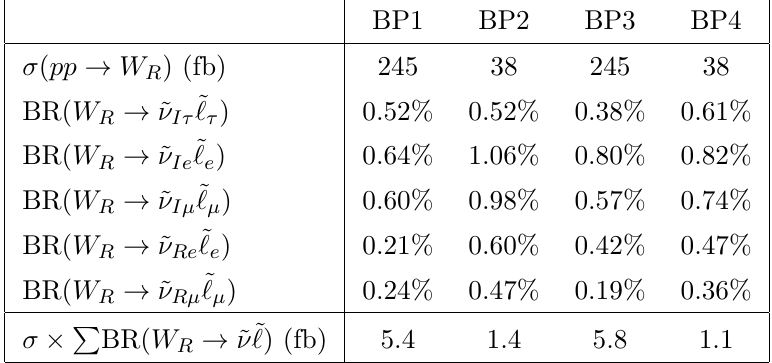
Table 3 . W R -boson production cross sections for proton-proton collisions at a center-of-mass p energy s = 13 TeV, and W R branching ratios to sleptonic (cid:12)nal